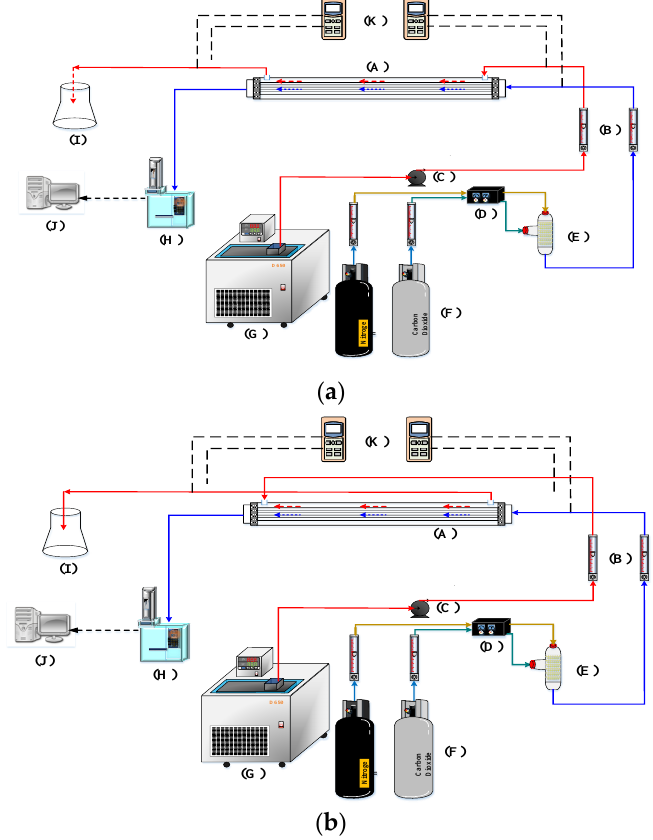
Figure 5. Schematic diagram of the experimental setup for CO 2 absorption with MEA by hollow- fiber gas–liquid membrane contactors. ( a ) Concurrent-flow operation; ( b ) Countercurrent-flow operation. (A) Hollow fiber membrane module; (B) Flow meter; (C) Pump; (D) Mass flow controller; (E) Mixer; (F) Gas cylinder; (G) Thermostatic tank; (H) Chromatograph; (I) Beaker; (J) Monitor; (K) Temperature indicator.